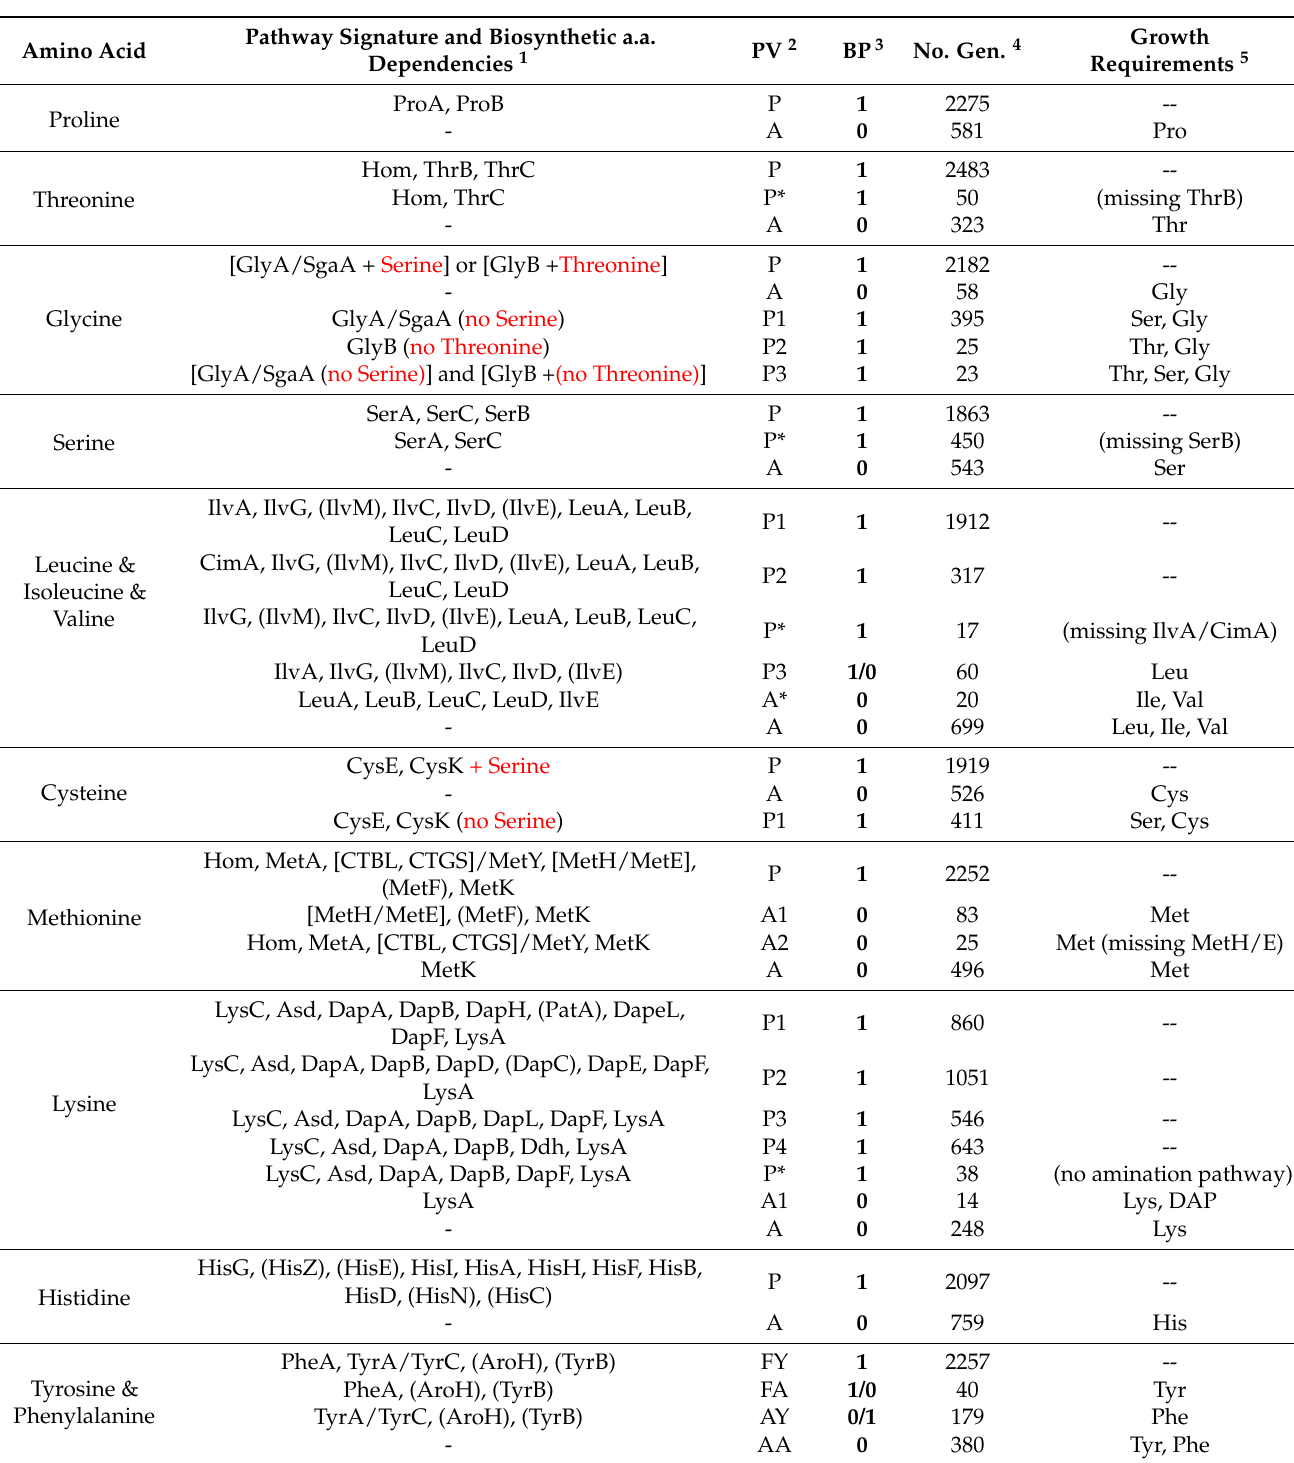
Table 1. In silico reconstruction and phenotype prediction for amino acid biosynthesis in HGM reference